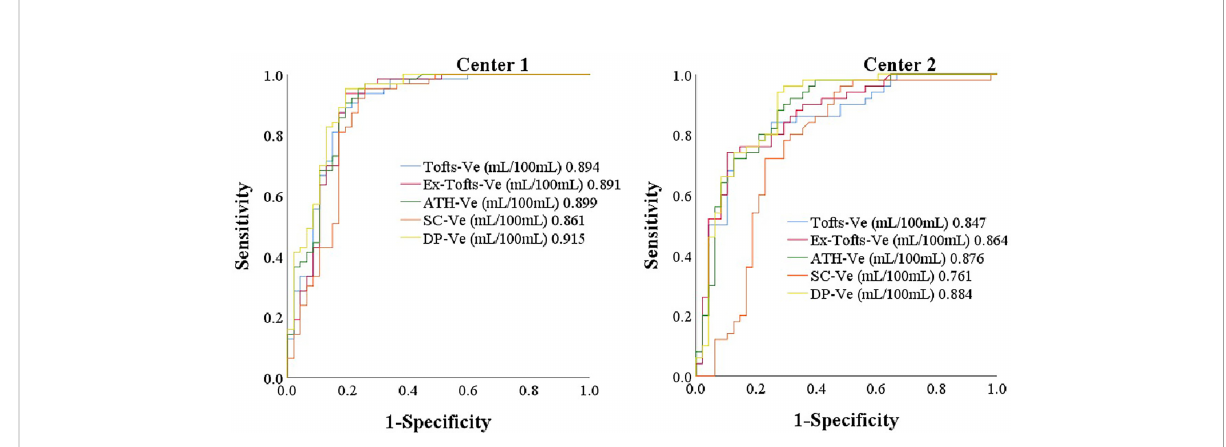
FIGURE 4 The ROC of parameter Ve from the fi ve models (Ex-Tofts, Tofts, ATH, SC, and DP) in Center 1 and Center 2, respectively.